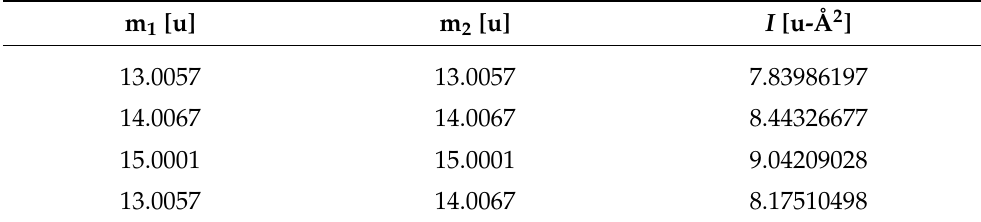
Table 3. Moment of inertia of molecules considered in Figure 1b.